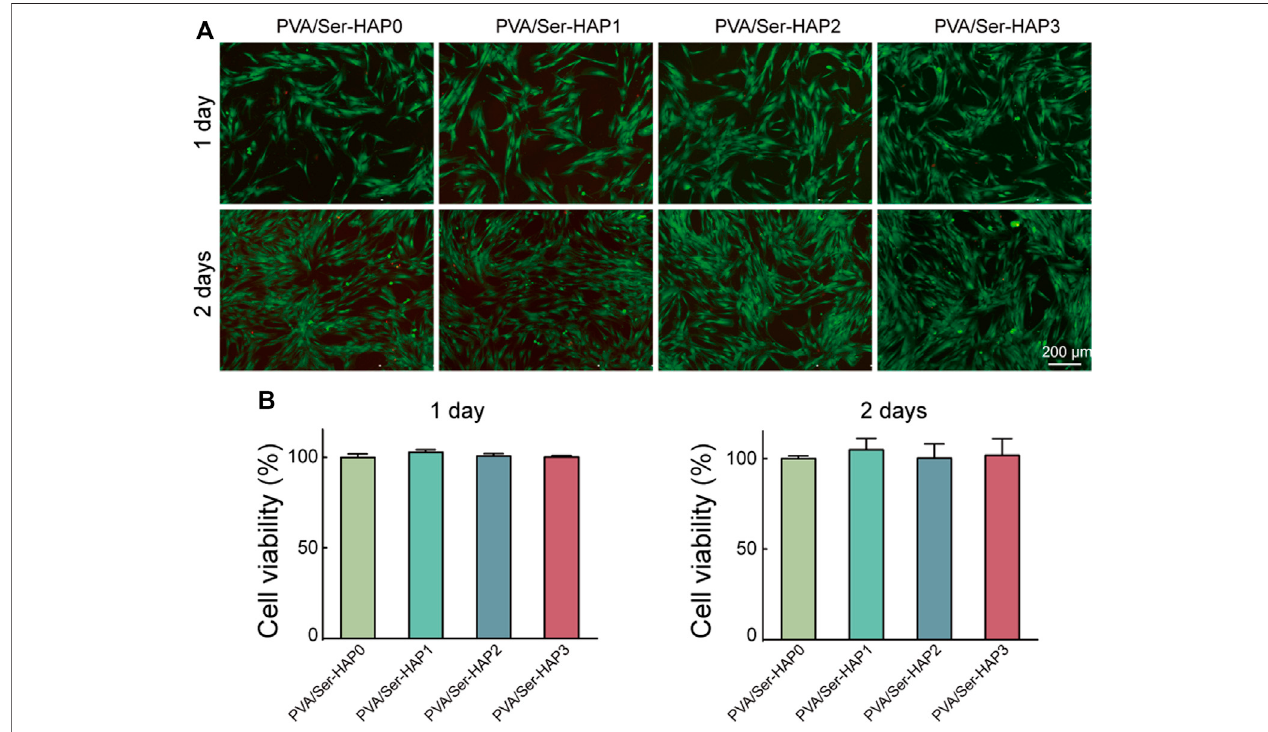
FIGURE 6 | Biological compatibility of PVA/Ser-HAP membranes. Live/Dead staining (A) and CCK-8 assay (B) of hPDLSCs on the PVA/Ser-HAP membranes.